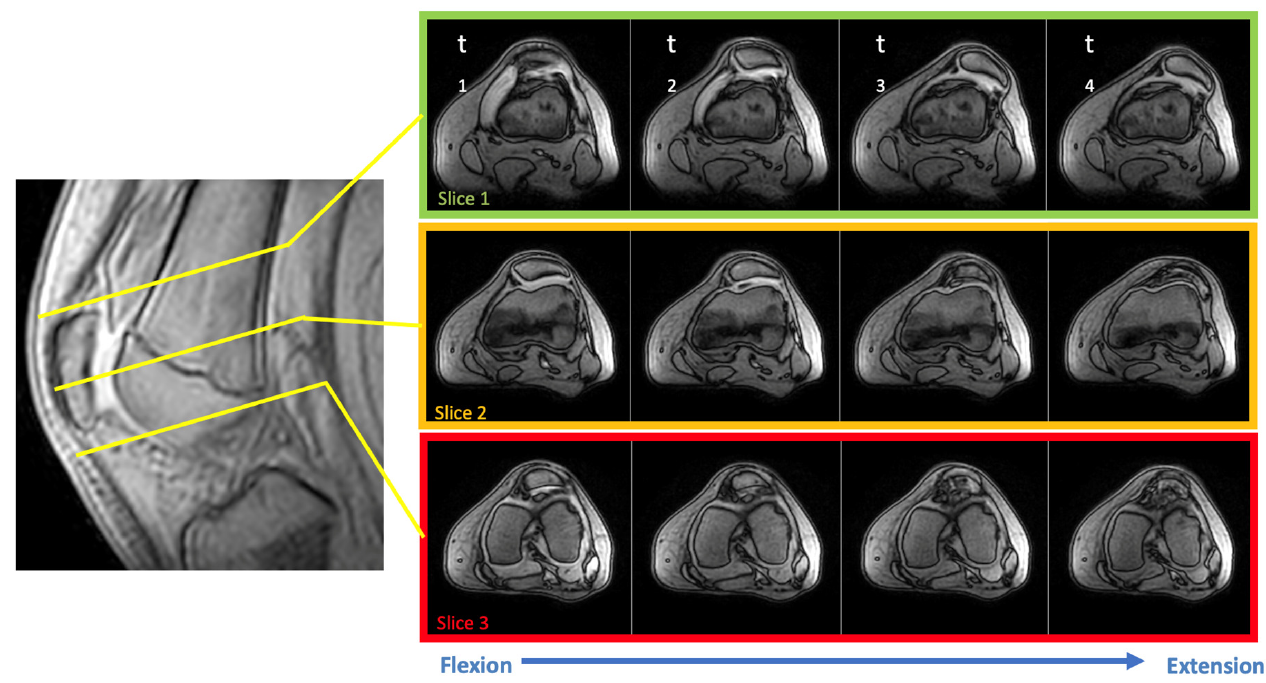
Figure 5. Real-time dynamic MRI measurement of patellar maltracking in the left knee of a symp- tomatic patient. In accordance with the technique described by Frings et al. [5], three slices in transverse orientation were followed by one sequence in sagittal plane orientation. Four measure- ment time points (t 1 –t 4 ) are shown. During active repetition of knee flexion and extension, patellar tracking could be measured in real time.